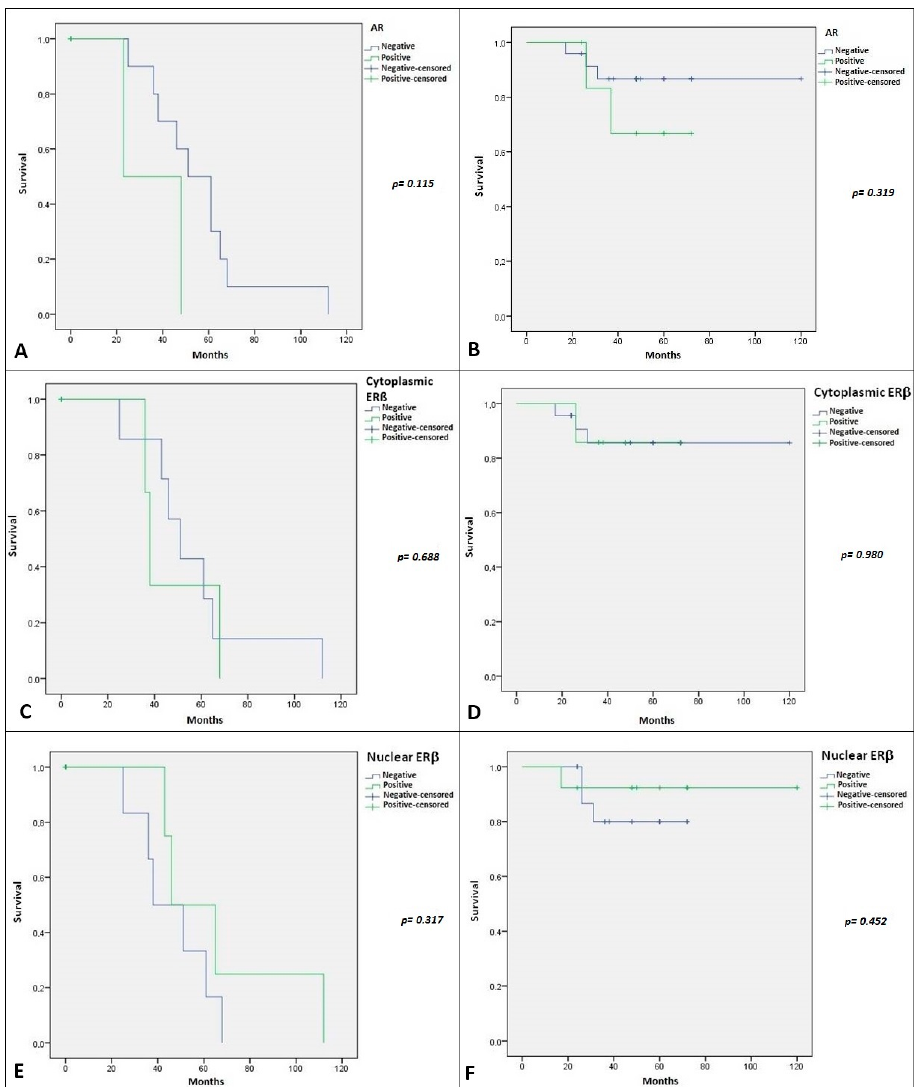
Figure 7. ( A )Kaplan–Meier plot for disease-free survival (DFS) in patients with SGT stratified by AR IHC expression. The green line represents patients with AR nuclear positivity; ( B ) Kaplan–Meier plot for Overall survival (OS) in patients with SGT stratified by AR IHC expression. The green line represents patients with AR nuclear positivity; ( C ) Kaplan–Meier plot for DFS in patients with SGT stratified by cytoplasmic ER β IHC expression. The green line represents patients with cytoplasmic ER β positivity; ( D ) Kaplan–Meier plot for OS in patients with SGT stratified by Cytoplasmic ER β IHC expression. The green line represents patients with cytoplasmic ER β positivity; ( E ) Kaplan–Meier plot for DFS in patients with SGT stratified by nuclear ER β IHC expression. The green line represents patients with nuclear ER β positivity; ( F ) Kaplan–Meier plot for OS in patients with SGT stratified by nuclear ER β IHC expression level. The green line represents patients with nuclear ER β positivity.